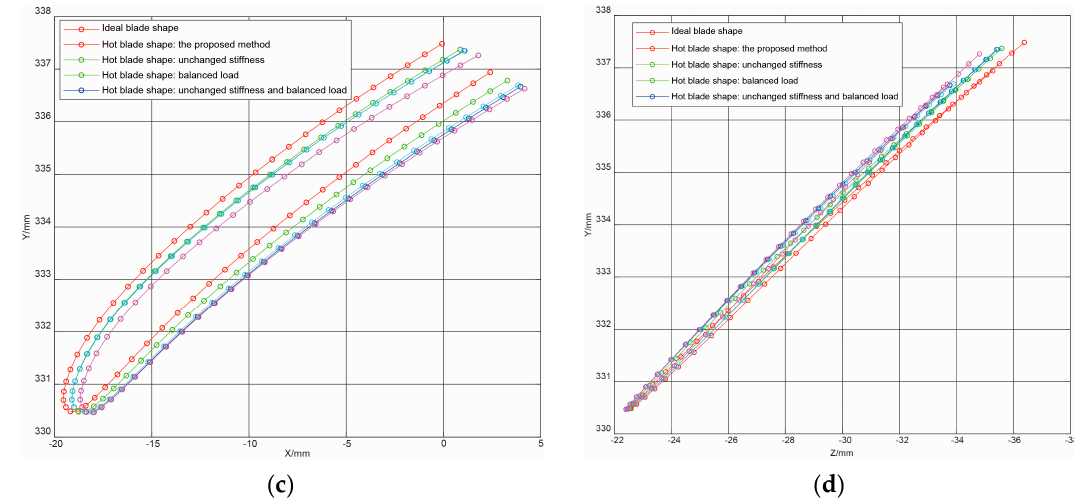
Figure 7. Deviations of the nodes at the leading edge of the blade top. ( a ) Spatial location of nodes; ( b ) projection in XZ plane; ( c ) projection in XY plane; ( d ) projection in YZ plane.